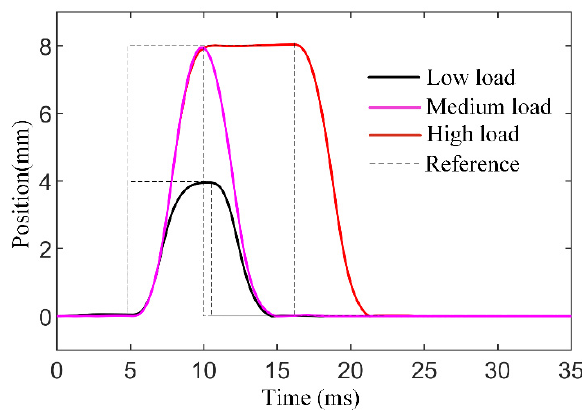
Figure 12. Results of flexible valve motion control.